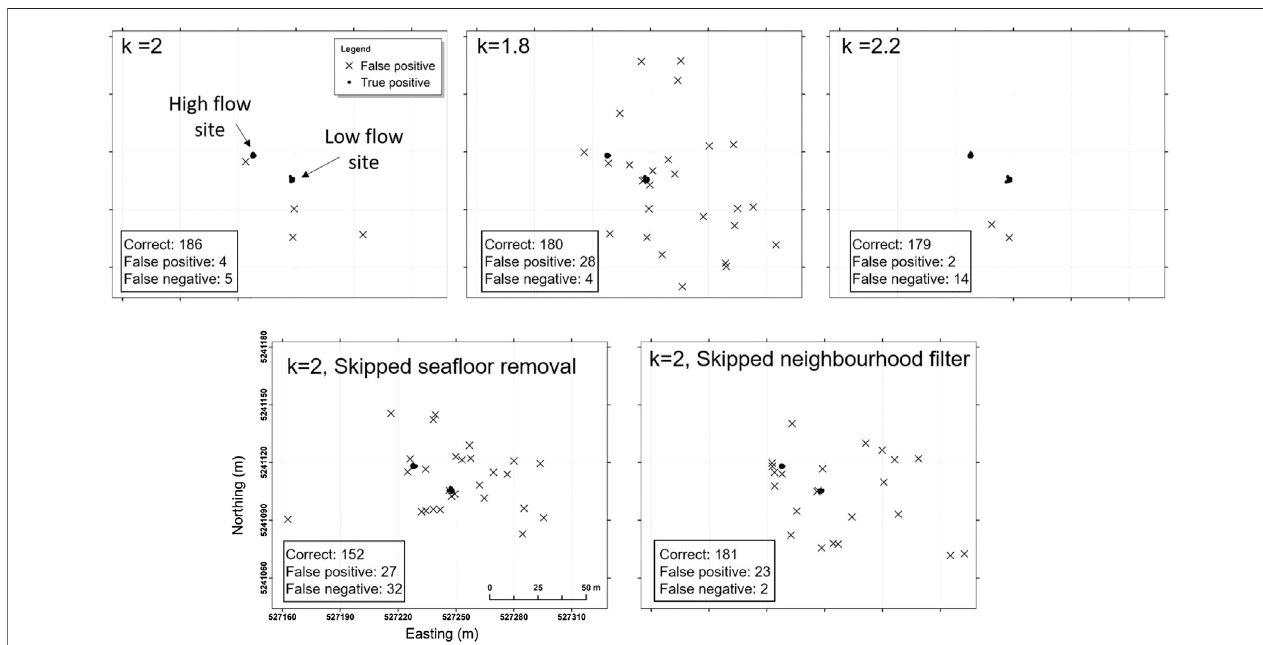
FIGURE 10 | Maps displaying false positives for the primary and alternative processing methods. Grids are in Easting (m) and Northings (m) using WGS84 UTM Zone 55S projection coordinates. False positives are shown by crosses, and correctly identi fi ed seeps are solid circles. The two clusters ’ locations of correct seeps are the locations of the high and low fl ow deployments.